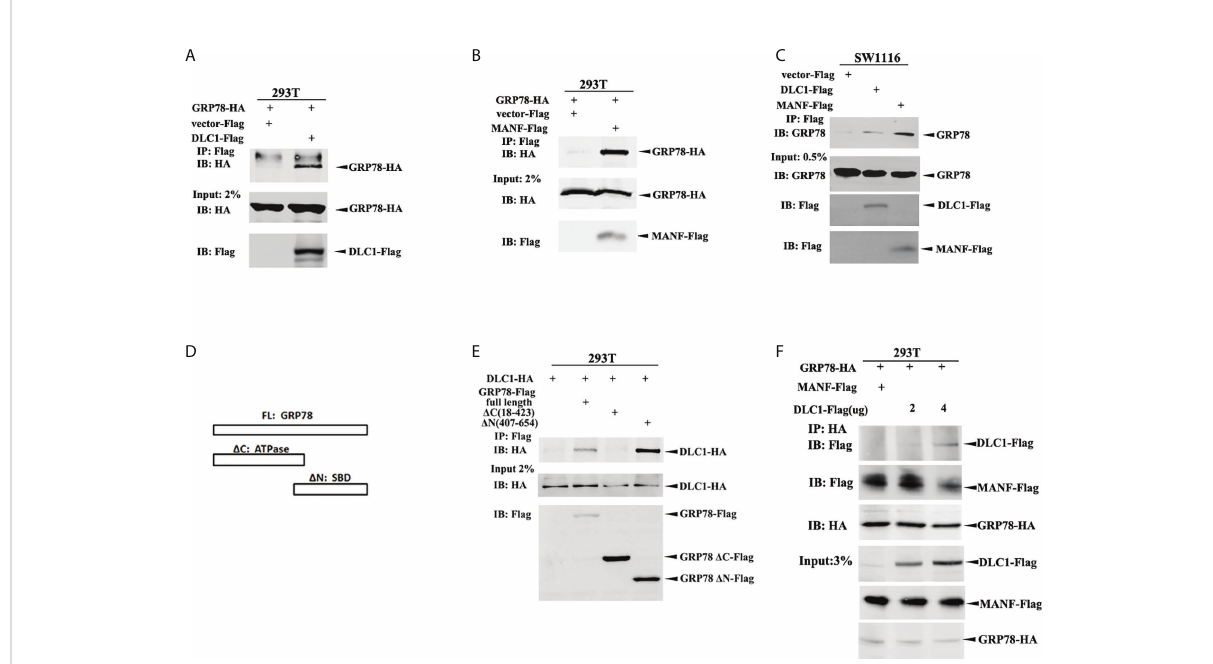
FIGURE 5 DLC1 competed binding to GRP78 to release MANF. (A) GRP78-HA interacted with DLC1-Flag in HEK-293T cells. (B) GRP78-HA interacted with Flag-MANF in HEK-293T cells. (C) The exogenous DLC1-Flag or MANF-Flag interacted with endogenous GRP78 in colon cells SW1116. (D) We constructed truncations of GRP78 by domains (ATPase domain and SBD domain) and tagged with Flag to participate in Co-IP. (E) The D N truncation (SBD domain) and full length of GPR78 interacted with DLC1 in HEK-293T cells. (F) Increasing amount of DLC1-Flag gradually abolished the interaction between GRP78-HA and